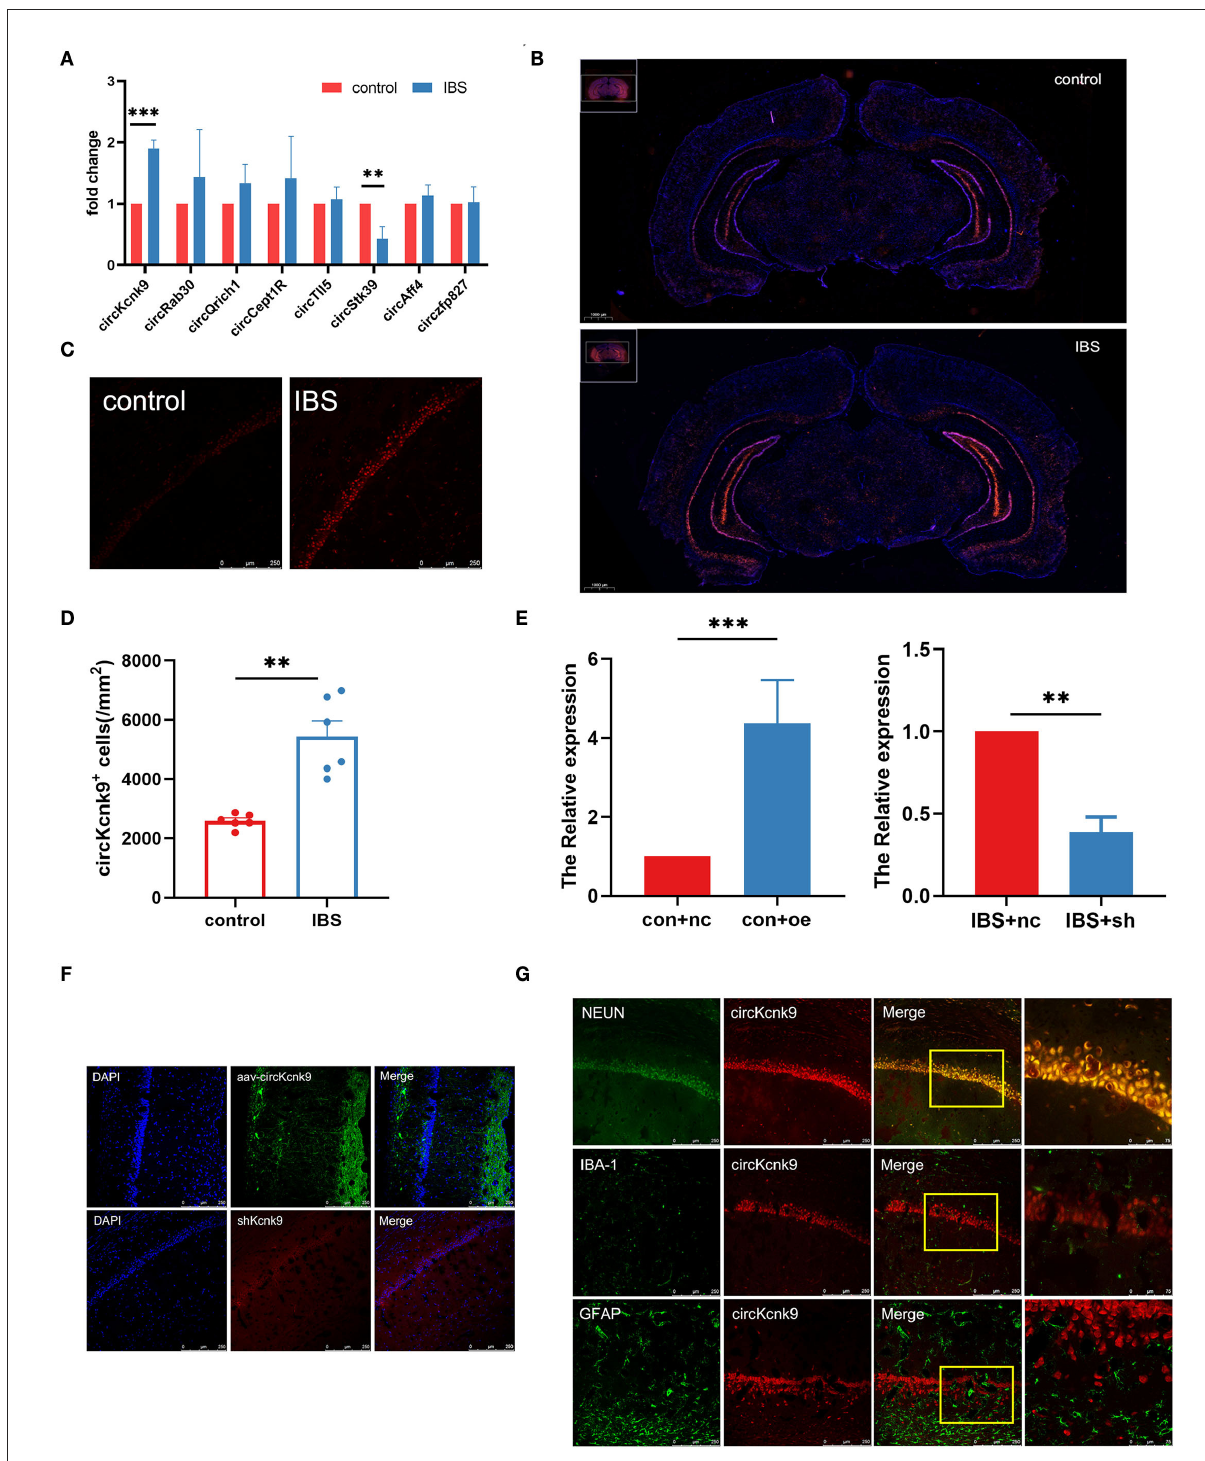
FIGURE2 Increased CircKcnk9 is localized in the neurons of hippocampus in IBS-like rats and the expression of circKcnk9 can be modified after aav-circKcnk9 or shcircKcnk9 treatment. (A) qPCR quantification of the circular RNA associated with chronic visceral pain. N = 6, ** p < 0.01, *** p < 0.001. (B) Distribution map of circKcnk9 content in brain slices. Scale bar, 1000 µ m. (C,D) Immunofluorescence representative images and quantification of circKcnk9 numbers in the CA1 of IBS-like and control rats. N = 6, scale bar, 250 µ m, ** p < 0.01. (E) The expression of CA1 circKcnk9 after treatment with aav-circKcnk9 in controls and shcircKcnk9 in IBS-like rats. N = 5, ** p < 0.01, *** p < 0.001. (F) Representative immunofluorescence traces of aav-oe1/shRNA in hippocampal CA1. Scale bar, 250 µ m. (G) Confocal images of CA1 circKcnk9 expression with NEUN, IBA-1 and GFAP. Scale bar, 250 µ m. IBS, irritable bowel syndrome; DAPI, nucleus staining